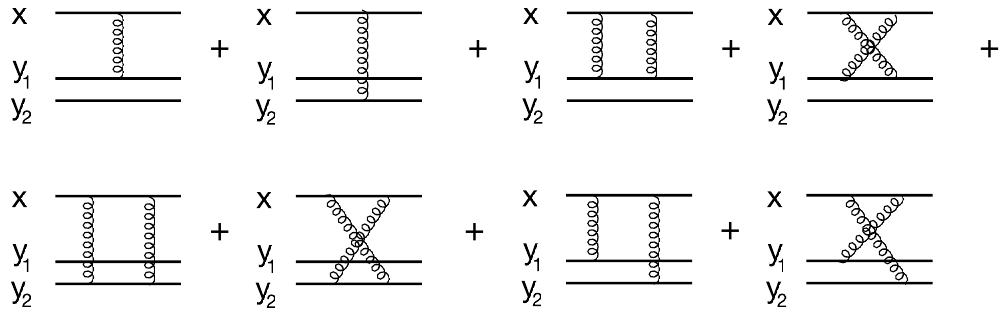
Figure 1 . The one, two ((cid:12)gure 1a) and three ((cid:12)gure 1b) gluon exchange contributions to the algebra.